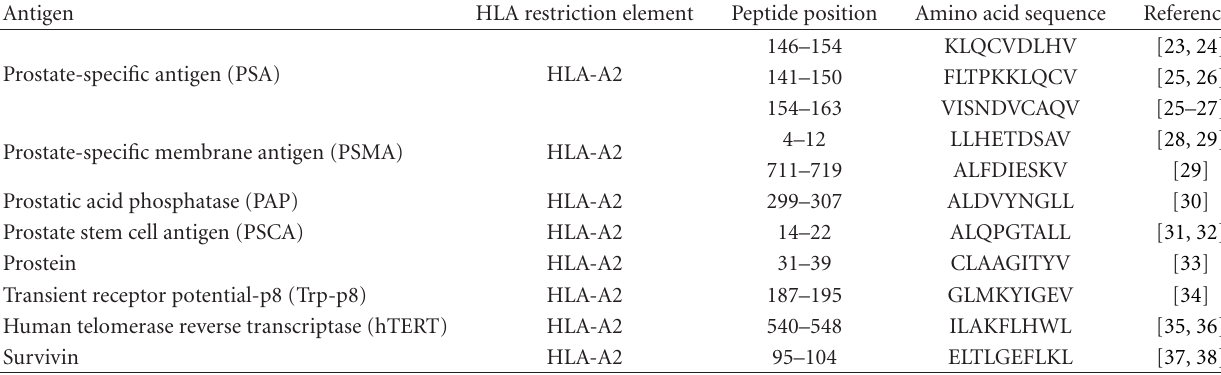
Table 1: PCa-associated antigen-derived CD8 + T-cell epitopes used for DC-based